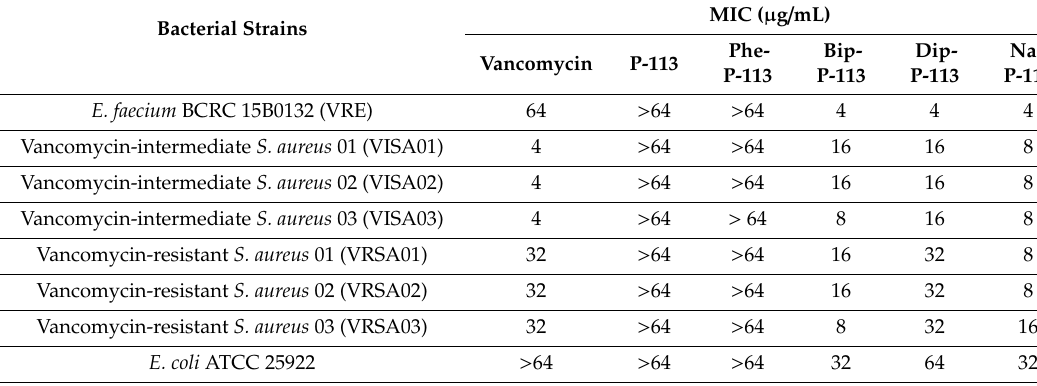
Table 2. MICs of Vancomycin, P-113, Phe-P-113, Bip-P-113, Dip-P-113 and Nal-P-113. The experiments were performed in triplicate.